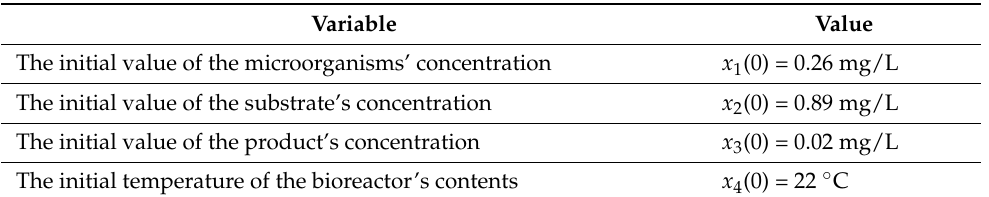
Table 1. Initial values of the fermentation process in the studied bioreactor. Variable